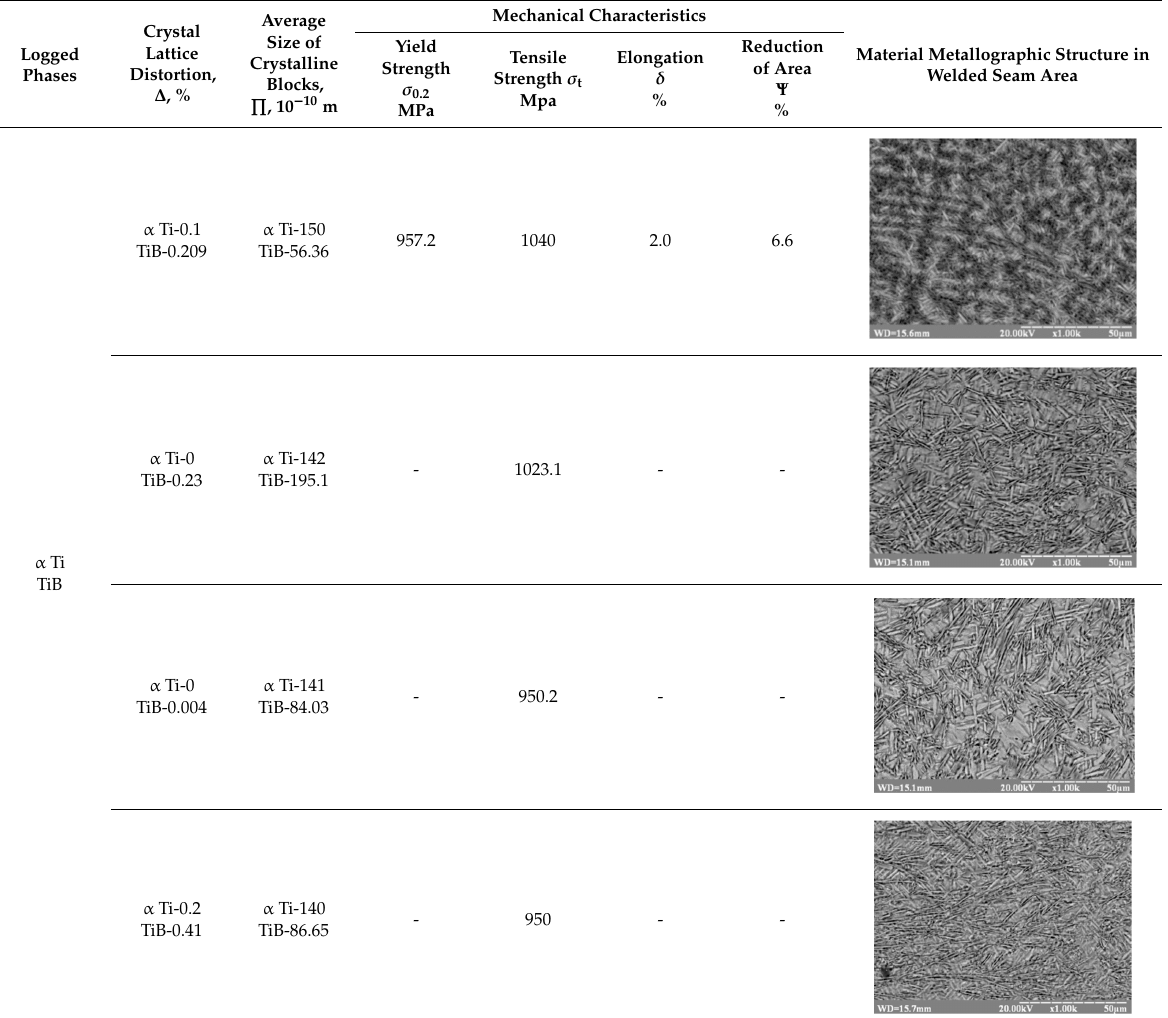
Table 2. Characteristics of the materials of Ti-TiB welded joints produced under various modes of electron-beam welding. No. of